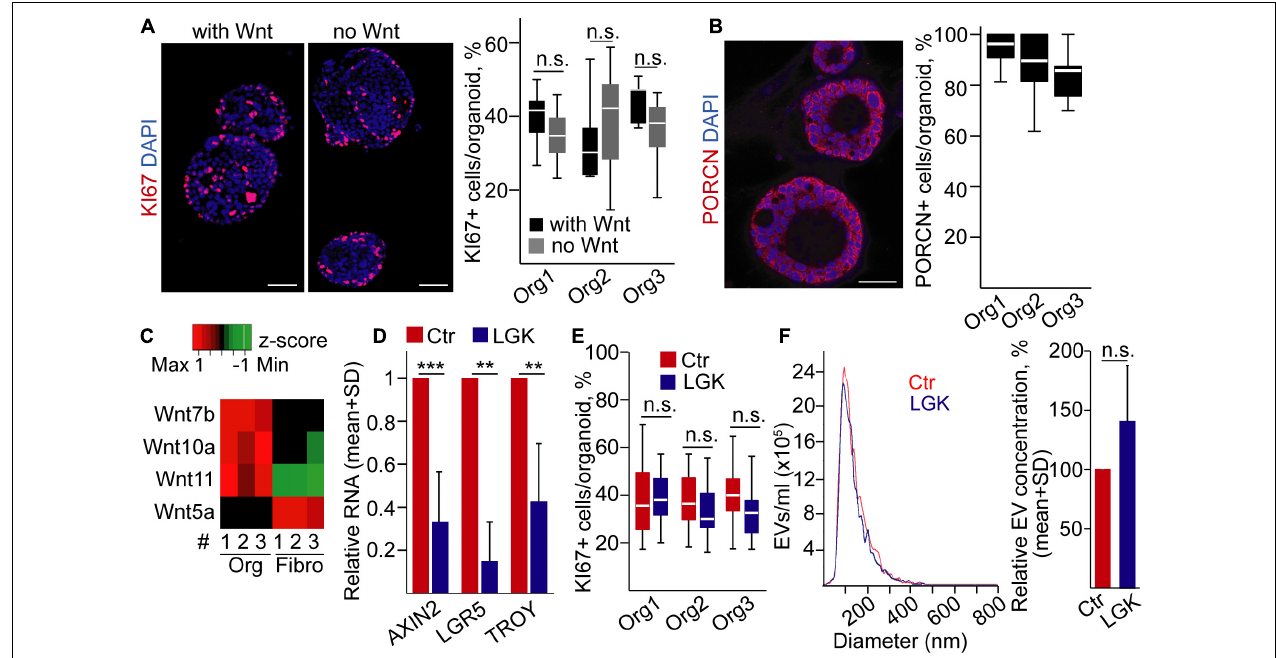
FIGURE 2 | Wnt secretion is uncoupled from cell proliferation and EV release in human pancreatic ductal adenocarcinoma (PDAC) organoids. (A) Immunostaining for the proliferation marker KI67 and quantification of the confocal microscopic images for three organoid lines. Representative images are shown from organoid #1. In some experiments, organoids were cultured with or without recombinant Wnt3a (with Wnt and no Wnt, respectively, 100 ng/ml). (B) Confocal microscope analysis of organoids immunostained for Porcn and quantification of the images. (C) The expression level of the indicated Wnt genes in PDAC organoids and fibroblasts (RT-qPCR, n = 3). Data normalized to housekeeping were z -score transformed. Red and green colors indicate higher and lower RNA levels, respectively. The black color shows the lack of expression (Ct > 36). (D) Fold change of RNA levels of AXIN2 , LGR5 , and TROY (RT-qPCR). Results from samples cultured with LGK974 and normalized to HPRT1 were compared to the untreated controls ( n = 3 from three organoid lines). (E) The percentage of KI67 + cells in the organoids with or without LGK974 (analysis of confocal microscopic images). (F) Representative images of NTA measurements (left panel) and their quantification (right panel, normalized to 10 6 cells, n = 5) in control samples and after treatment with LGK974. For panels (A,B,E) , experiments were repeated three times for each organoid line. Mann–Whitney U -test (A,E) , paired t -test (D) , or one-sample t -test (F) were used with ** p < 0.01 and *** p < 0.005. p > 0.05 was considered non-significant. Scale bars: 50 µ m (A,B)